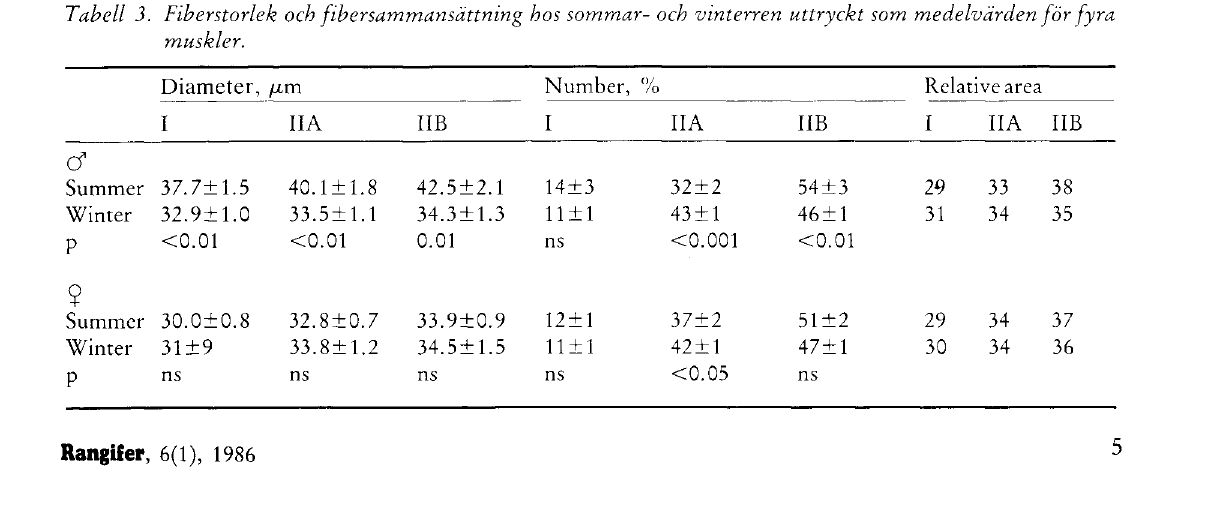
Table 3. Fibre-size and -composition in summer and winter reindeers expressed as values of four muscles. Tabell 3. Fiberstorlek och